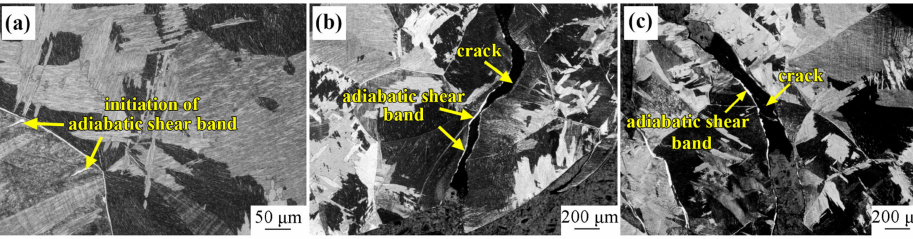
Figure 9. Microstructure of WM sample at different strain rates: ( a ) 1000 s − 1 ; ( b ) 2000 s − 1 ; ( c ) 3000 s − 1